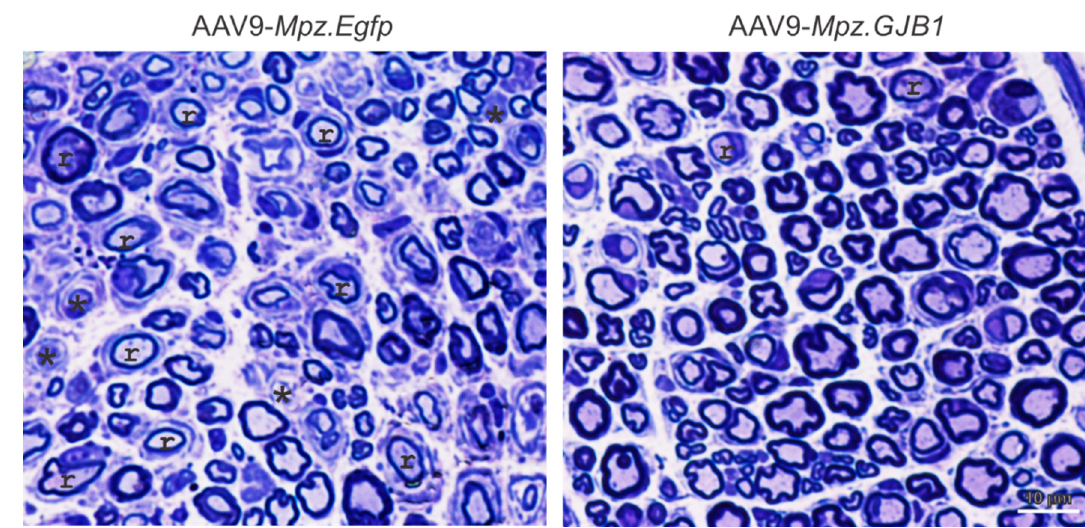
Figure 1. Effects of AAV9-mediated GJB1 gene replacement therapy in femoral motor nerves of the Gjb1 -null mouse model of CMT1X. Toluidine blue stained femoral motor nerve semithin sections from 10-month old Gjb1 -null mice treated post-onset at 6 months of age with intrathecal delivered mock vector (AAV9- Mpz.Egfp , left) or with AAV9- Mpz.GJB1 vector (right) in Schwann cells, shows improvement of myelination defects including the remyelinated (r) and demyelinated (asterisk) fibers. Modified from [34].